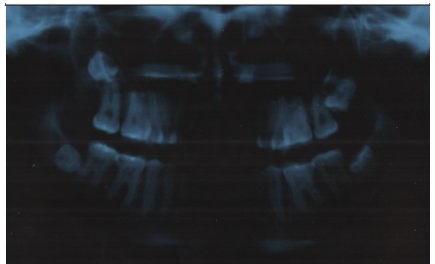
Figure 2: X-ray with the DU 18 into the maxillary